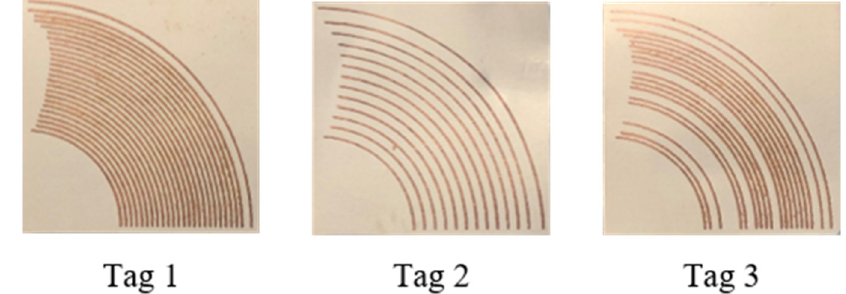
Figure 6. Photograph of fabricated CRFID tag instances.